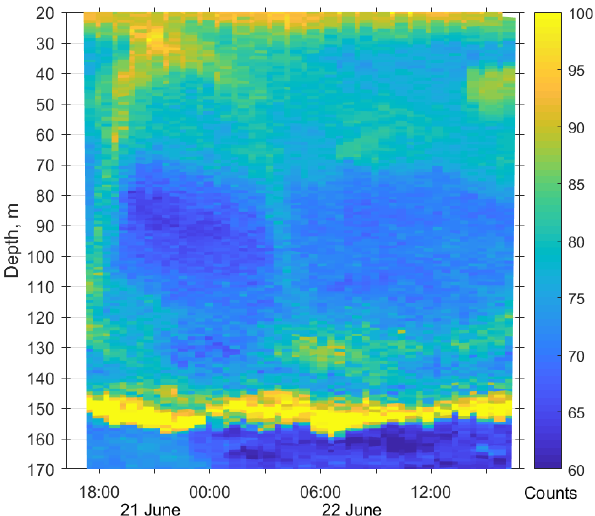
Figure 3. Diurnal motions of the sound-scattering layers in the oxic zone. The depth–time scatterplot for profiles of acoustic backscatter amplitude at 2MHz was obtained using the Aquadopp instrument at the moored profiler during verification study involving net sampling of zooplankton on 21 and 22 June 2010.